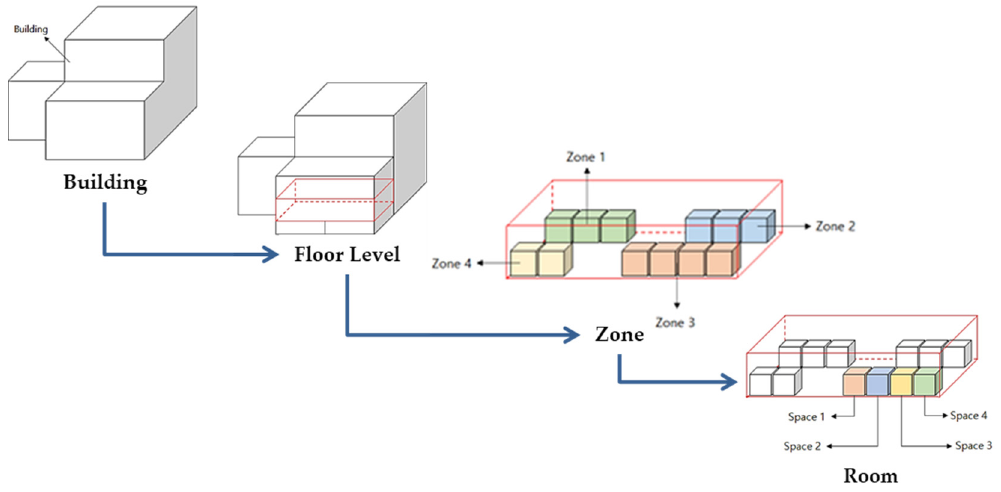
Figure 2. Hierarchy indoor space levels within a building.